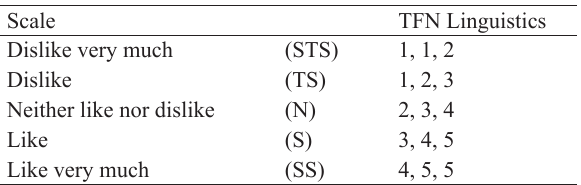
Table 6 Respondents’ weighting score of criteria based on the fuzzy-Eckenrode method